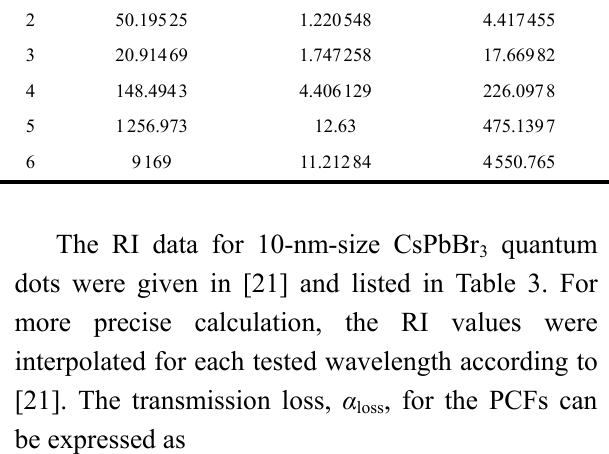
Table 3 Parameters of CsPbBr 3 QDs from